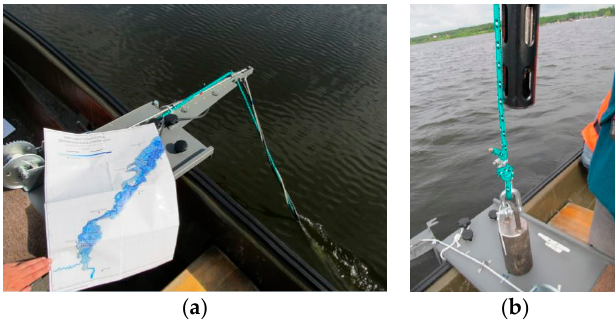
Figure 2. Mobile monitoring measurement system, ( a ): Bench with an extension arm; ( b ): probe with a weight.